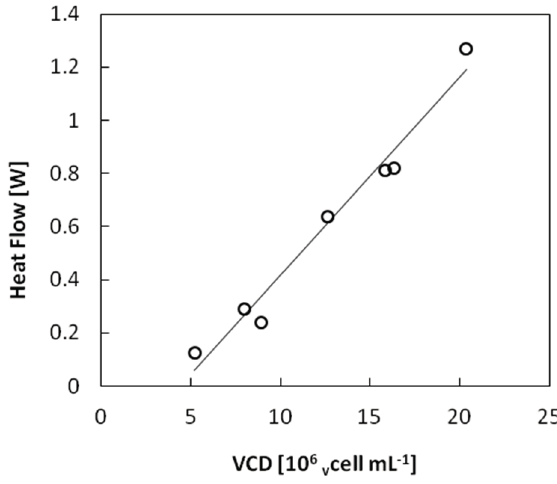
Figure 10. Heat flow rate and viable cell density linear model. The linear regression